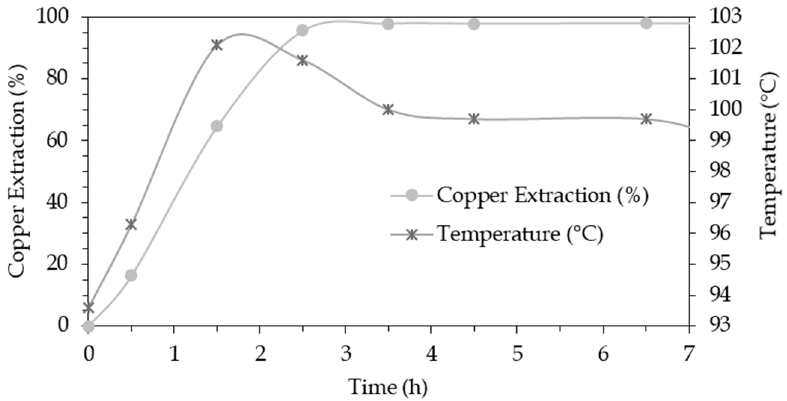
Figure 10. Copper extraction and temperature for the test 5 replicated.